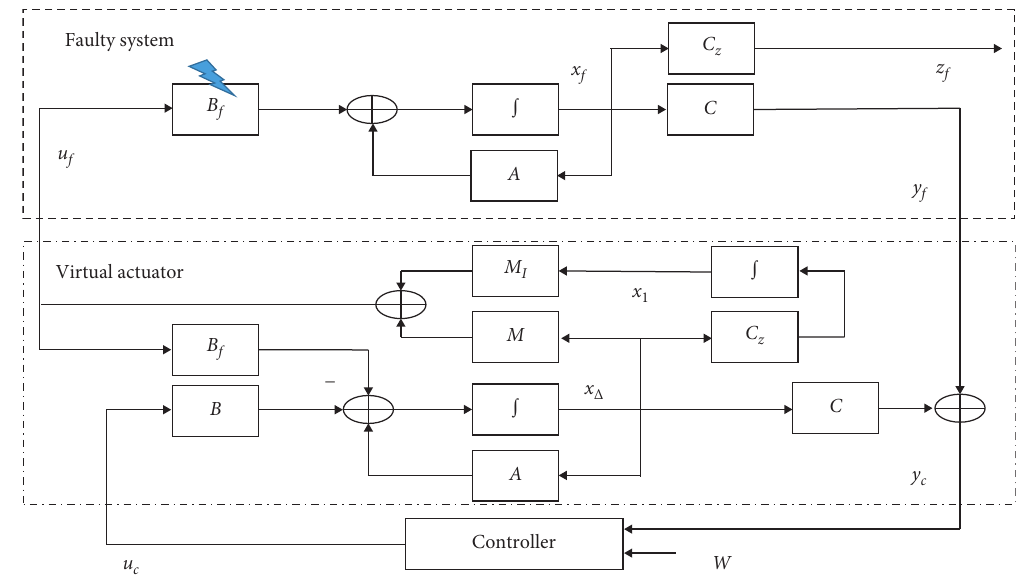
Figure 20: The simplified virtual actuator strategy with state residual x